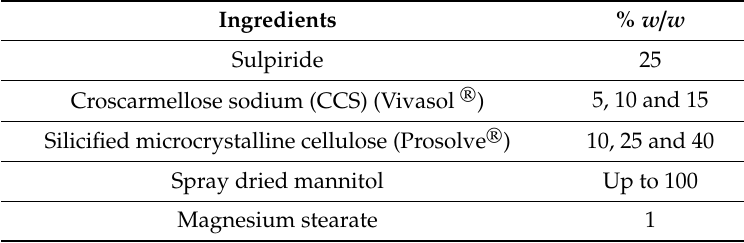
Table 8. The quantitative composition of sulpiride FDT